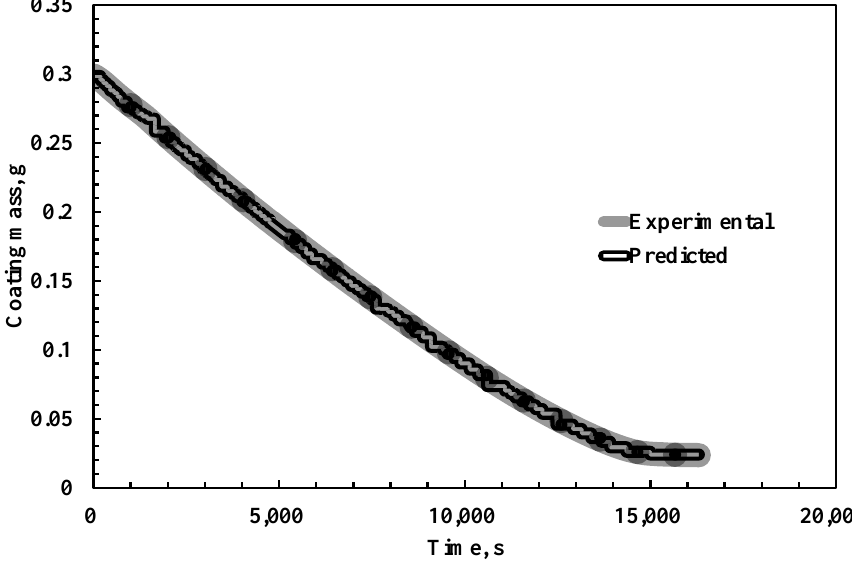
Figure 4. Comparison of model prediction with the experimental values for coating having 2011 micron initial coating thickness having poly(styrene), p -xylene, and TPP, 5.02%, 94.46%, and 0.52% respectively .